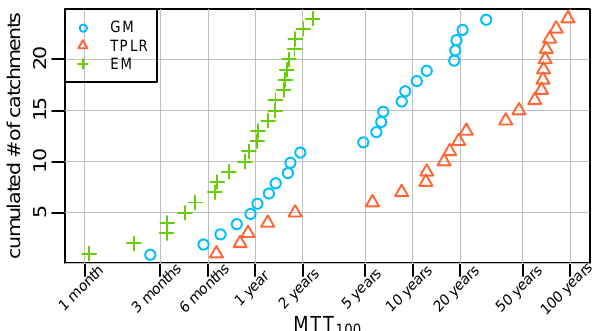
Figure 7. Cumulative distribution of catchment MTT estimates based on the three TF